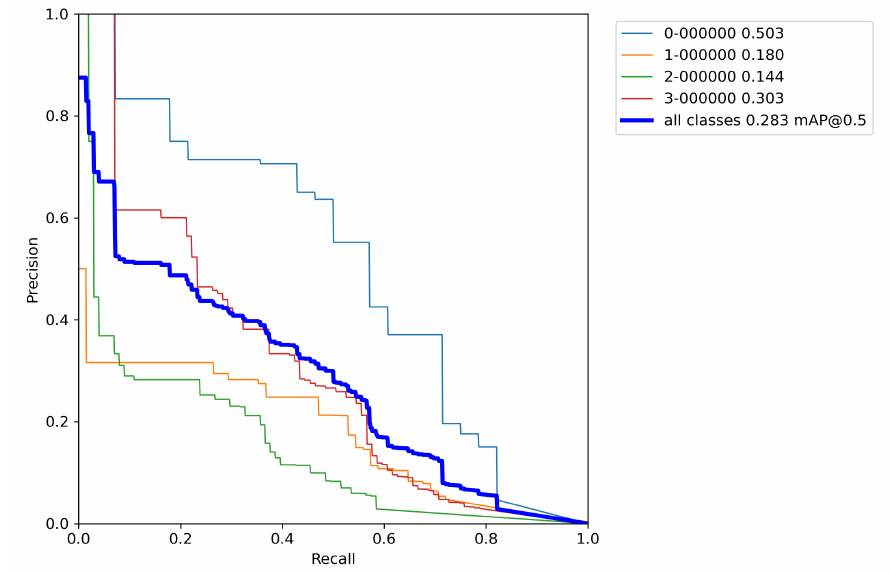
Figure A6. Model trained with classic augmentation techniques P–R curve—Experiment 1.